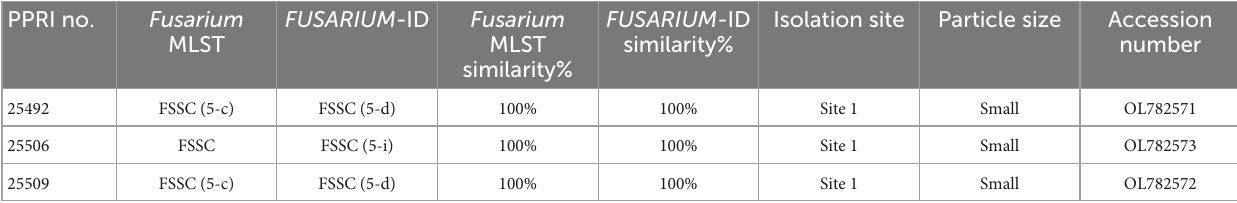
TABLE 7 Nucleotide BLAST (nBLAST TM ) results from the Fusarium MLST and FUSARIUM -ID databases for the FSSC. PPRI no.